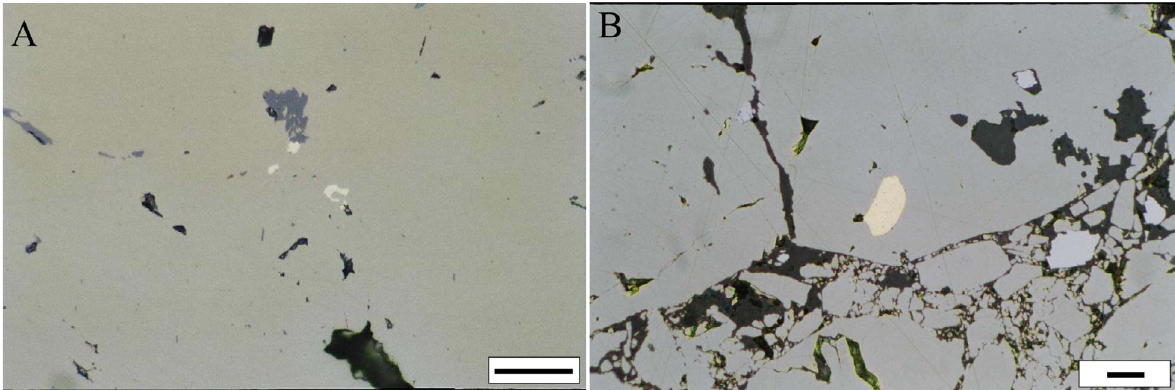
Figure 7. Photomicrographs (reflected light) images of gold grains from the Pozzo mine: ( A ) gold grains included in chalcopyrite. One of the grains is in contact with magnetite (gray) and ( B ) gold included in pyrite. Scale bar is 20 μ m.